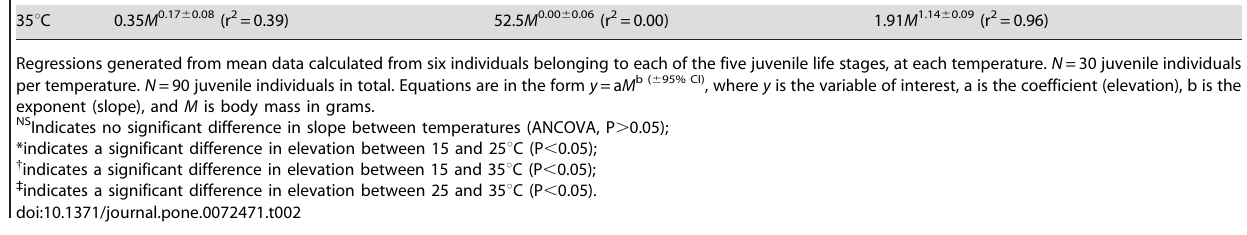
Jump distance (m) NS , { , ` Take-off angle (degrees) NS , * , { Jump energy (mJ per jump) NS , { ,